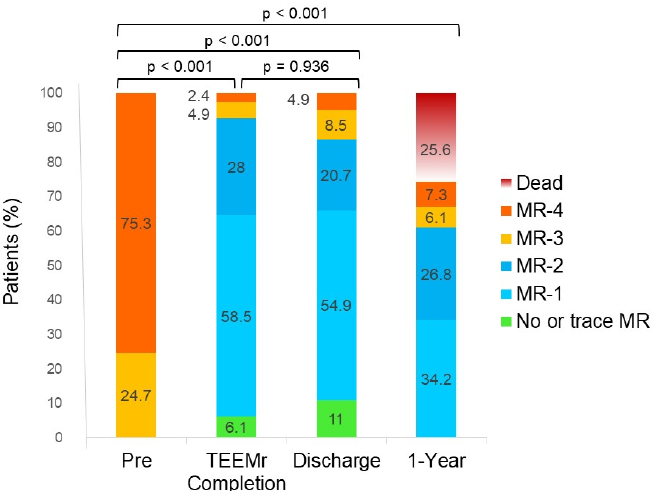
Figure 2. Mitral regurgitation grade at different time points. Columns illustrate the fractions of MR grades, of the cohort of patients, at baseline, at the completion of TEEMr, at discharge and at 1-year follow-up. rMR grades at completion of TEEMr, at discharge and at 1-year follow-up were significantly lower compared to pre-intervention MR grades. There was no significant difference in rMR grades at completion of TEEMr and at discharge. MR, mitral regurgitation; TEEMr, transcatheter edge-to-edge mitral valve repair.